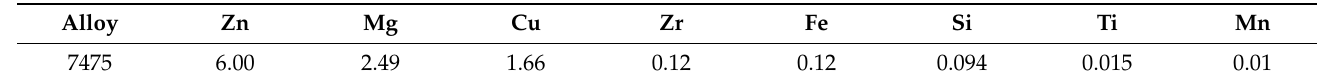
Table 1. Chemical composition of 7475 Al alloy (wt.%)